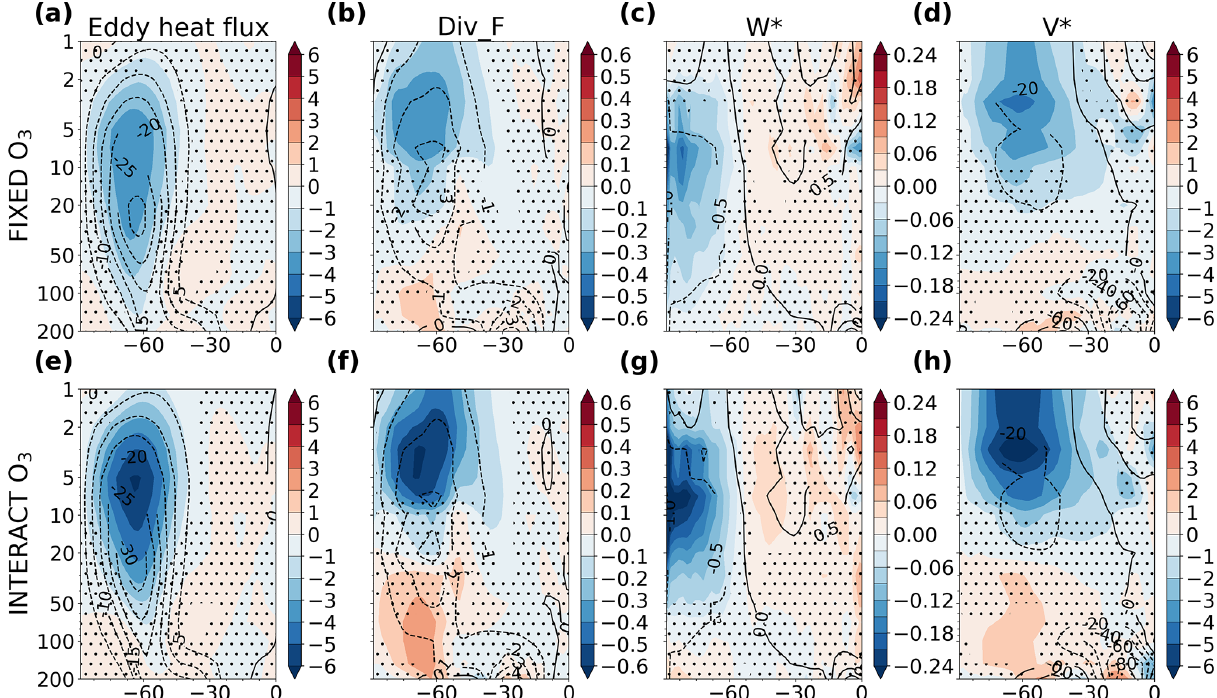
Figure 12. November latitude–height trends in the eddy heat flux ( a, e ; Kms − 1 per decade), the divergence of the EP flux ( b, f ; ms − 1 d − 1 per decade), the vertical residual velocity ( c, g ; mms − 1 per decade), and the meridional residual velocity ( d, h ; cms − 1 per decade) for the period 1958–2002 in FIXED O 3 (a–d) and INTERACT O 3 (e–h) . The overlaying contours in each panel show the corresponding climatologies. Stippling masks the trends that are not significant at the 95% confidence